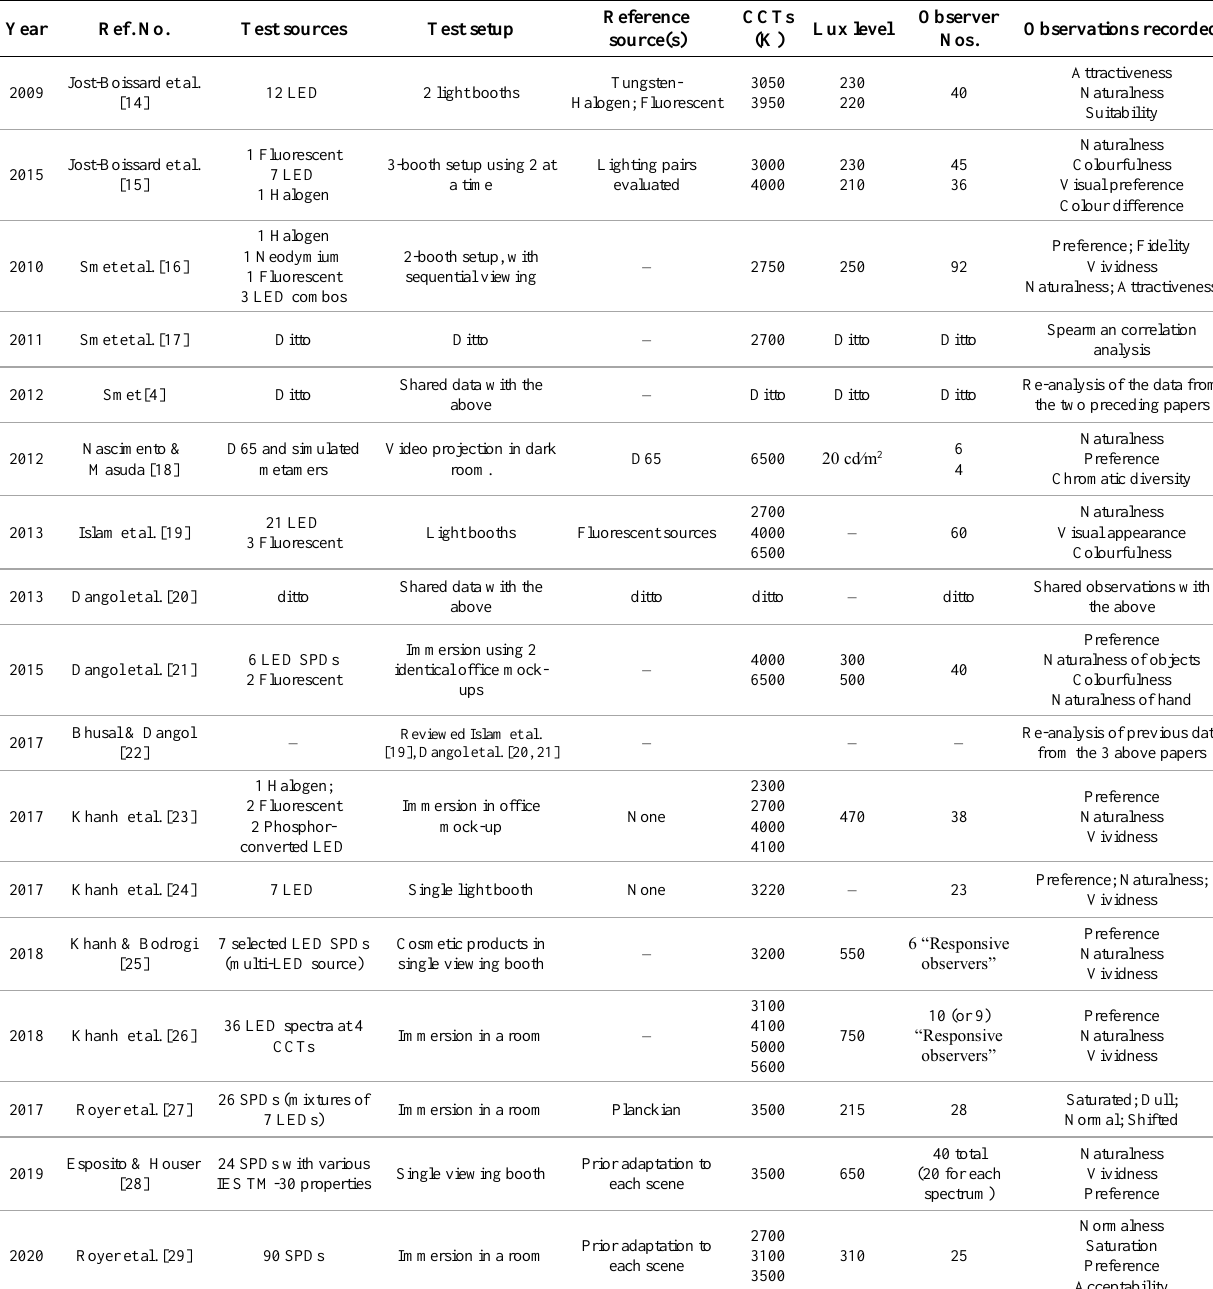
Table 2. Published data on lighting Colour Quality: Visual Assessments including